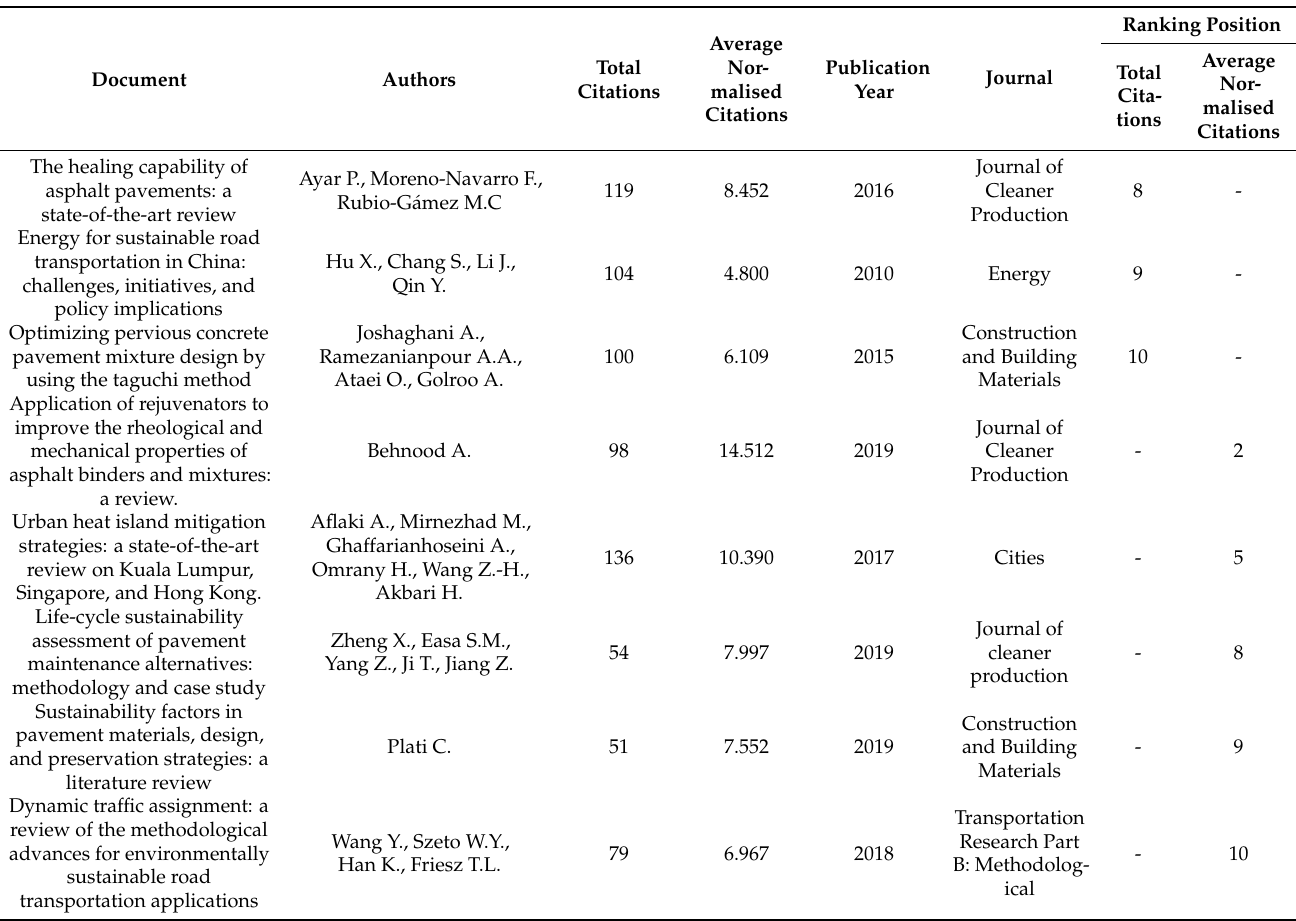
Figure 7. Overlay graph of the research field.